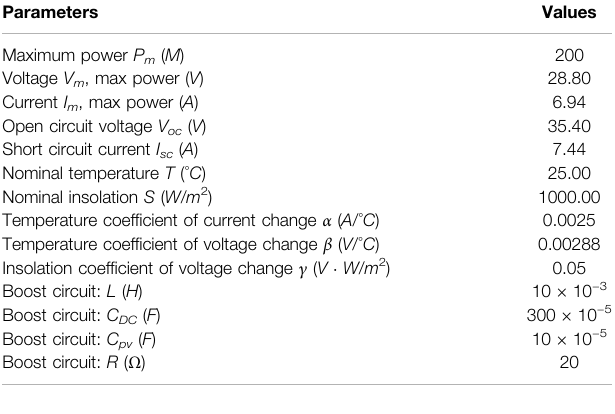
TABLE 1 | System simulation parameters.